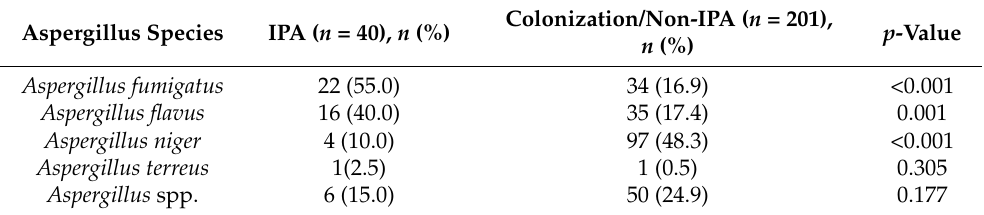
Table 1. Aspergillus species identified from respiratory specimen cultures in patients with and without invasive pulmonary